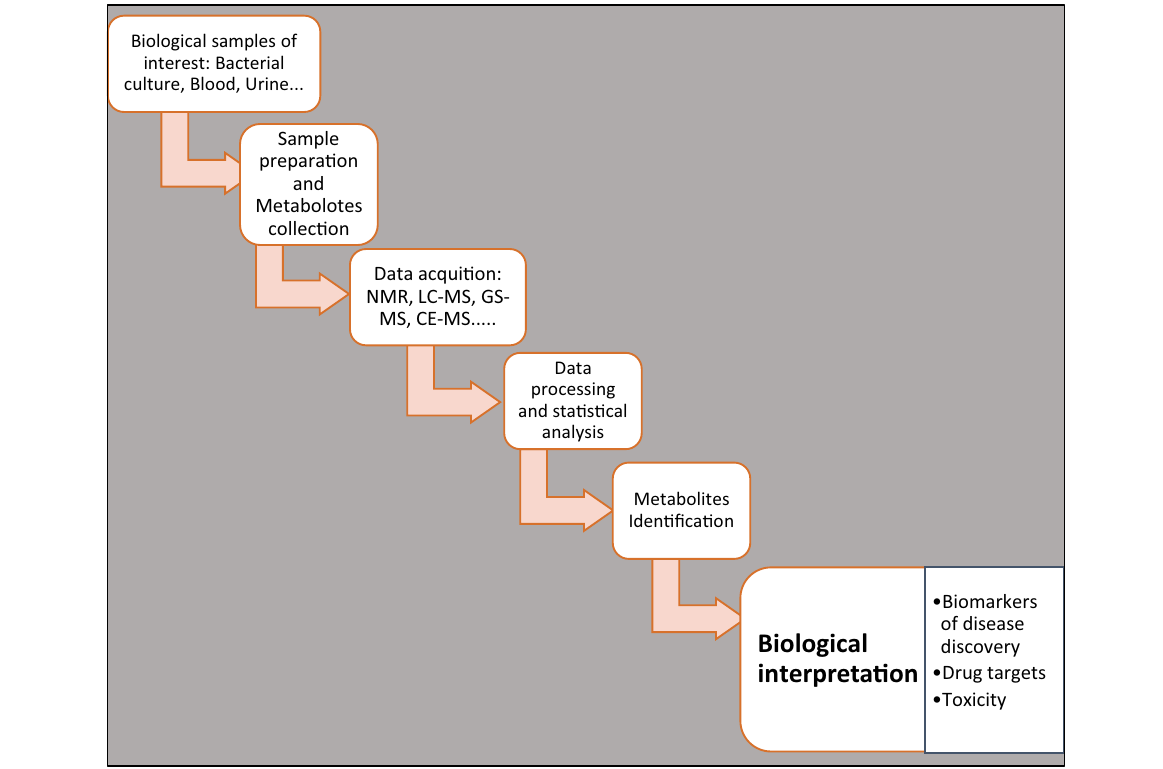
Fig. 3 Principles of metabolomics: the biological samples of interest are prepared to stop the metabolism (quenching) and the metabolites are collected. The data can be acquired by different analytical methods. The most common are NMR and Chromatography–MS. The data are processed and statistically analyzed. The metabolites resulting from any fluctuation are identified and biological interpretation gives the meaning of the resulting